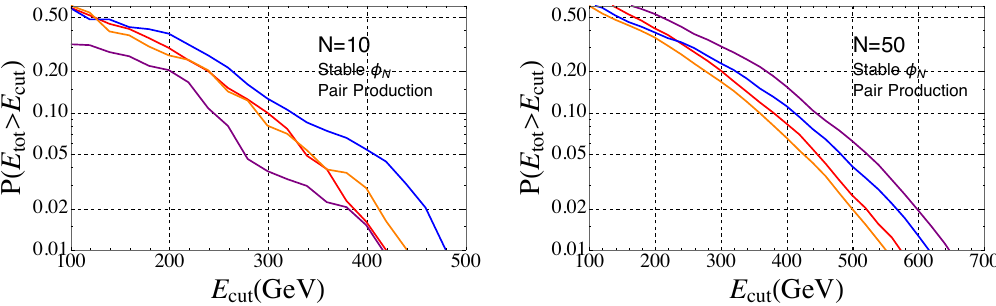
Figure 15. Fraction of events with total energy (including missing energy) above E were made in the Z -symmetric scenario where a SM = a = 0 in eqs. (3.1) and (3.2). Left: 10 scalars, 2 right: 50